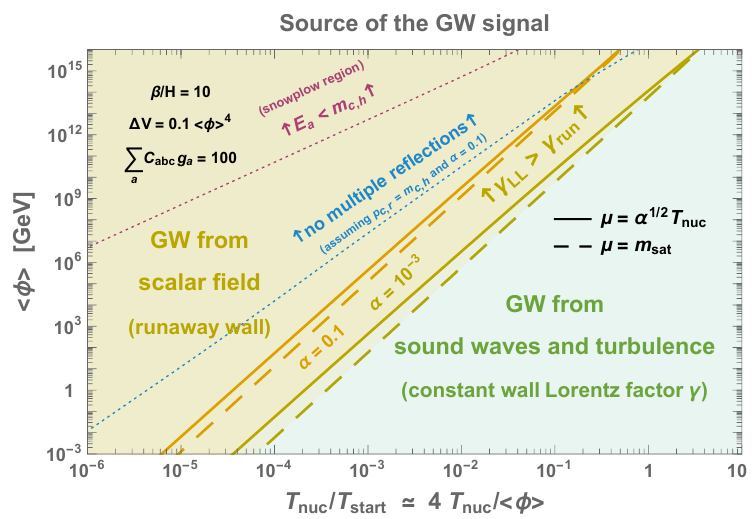
Figure 8 . In the yellow region, bubble walls collide before reaching the terminal Lorentz factor and GW are sourced by anisotropic stress tensor of the scalar field gradient localized at the bubble wall. In the green region, bubble walls reach their terminal velocity before colliding and GW are sourced by the anisotropic stress tensor of the fluid shells dragged by bubble walls. We vary the gauge coupling constant α from 10 − 3 to 0 . 1 and the IR cut-off µ from the thermal mass α 1 / 2 T nuc to the one m sat treated in section 3.4. We assumed that the pressure P is given by eq. (6.1). We can see that GW are sourced by scalar field in presence of large supercooling, or when the 1stOPT occurs at very high energies h φ i & 10 10 GeV . On the right of the blue dashed line drawn for α = 0 . 1 , effects due to multiple reflections of vector bosons in front of the wall must be considered, see section 4.4 and appendix D, but we leave them for further studies. On the left of the purple dashed lines